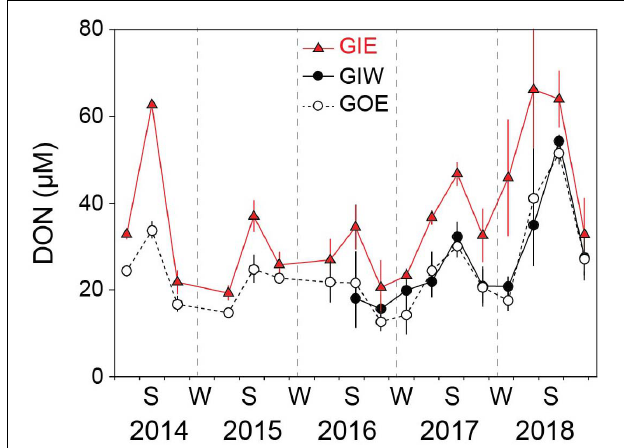
FIGURE 7 | Seasonal DON variations in the overlying water at station GIE, GIW, and GOE in Gyldensteen Coastal Lagoon from 2014 to 2018. Values are given as average ± se of samples taken once every 1–3 months from 2014 to spring 2016 ( n = 3) and triplicate monthly samples every month after that ( n =